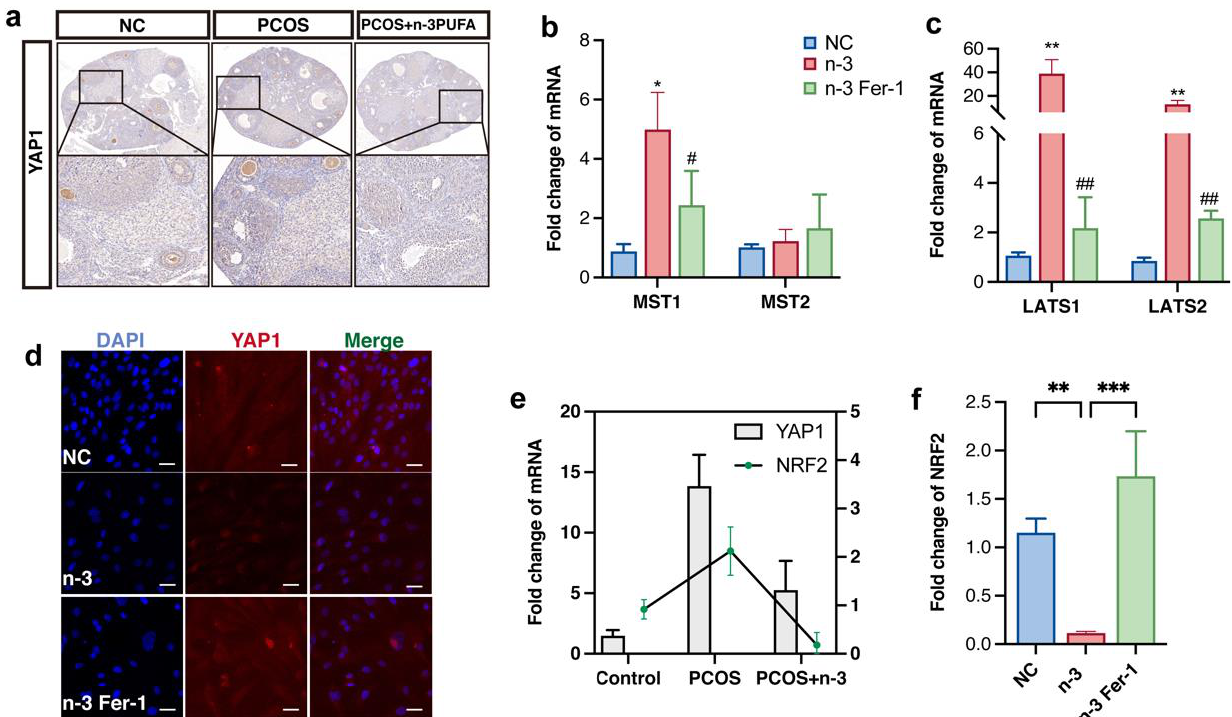
Figure 5. ( a ) Immunohistochemical staining of YAP1 in control, PCOS and PCOS + n -3 PUFA group mice ovary. n -3 PUFA addition group significantly decreased the expression of YAP1, implying an increase in p-YAP1. ( b , c ) Gene expression upstream of Hippo pathway which located upstream genes involved in the regulation of YAP1 phosphorylation. ( d ) Immunofluorescence staining of YAP1, after activation of the Hippo pathway, Yap1 is phosphorylated in the cytoplasm, and its total amount and nuclear distribution are reduced. ( e ) The expression trend of YAP1 and NRF2 was the same in Control, PCOS, PCOS + n -3 PUFA ovarian tissues ( f ) Further detection of the expression trends of NRF2 in vitro experiments showed that NRF2 were significantly down-regulated in the n -3 PUFA treatment group compared with the control group. Data are means ± SD (n = 3). * p < 0.05, ** p < 0.01, *** p < 0.001, # p < 0.05, ## p < 0.01.